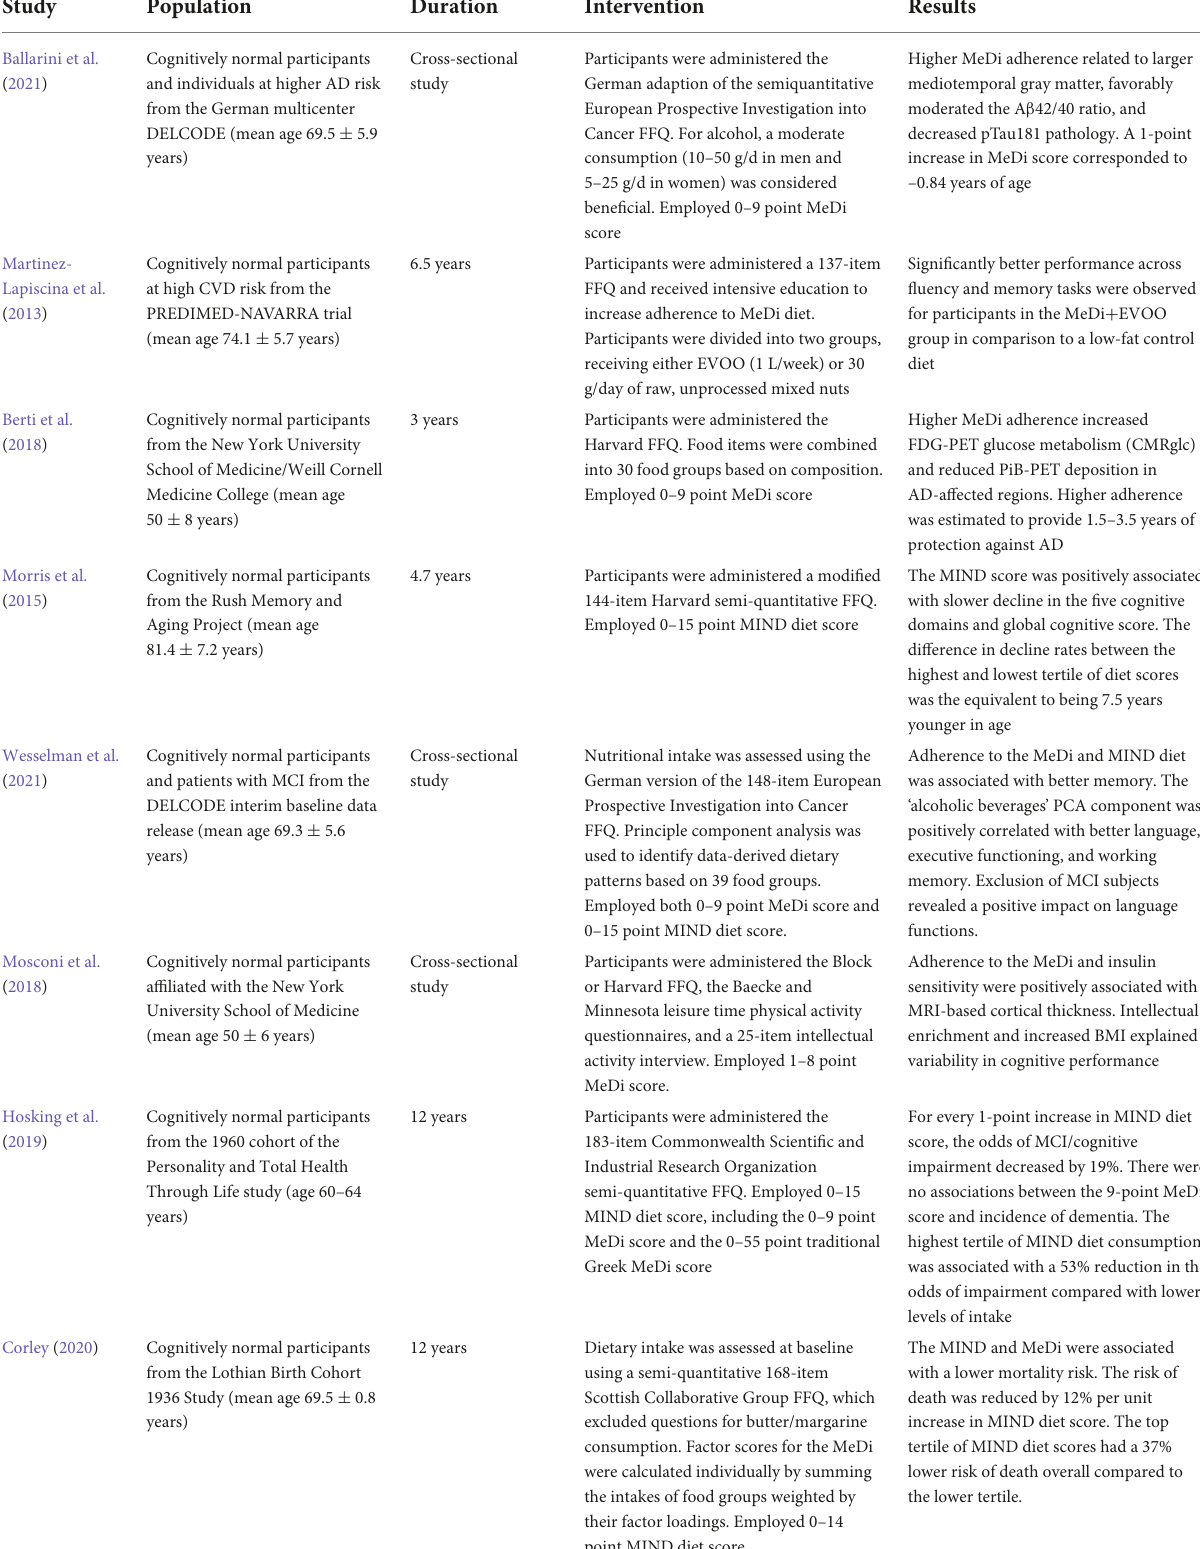
TABLE 2 Results of included studies investigating the relationship between MeDi/MIND diet adherence and cognitive